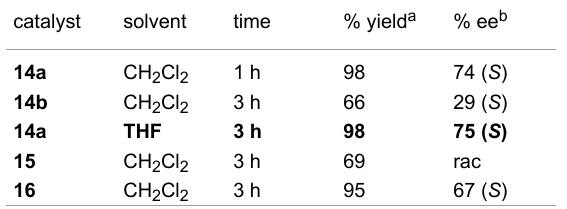
Table 4: Evaluation of cyclodiphosphazane-based triamide catalysts 14a/b – 16 (cf. Scheme 3).